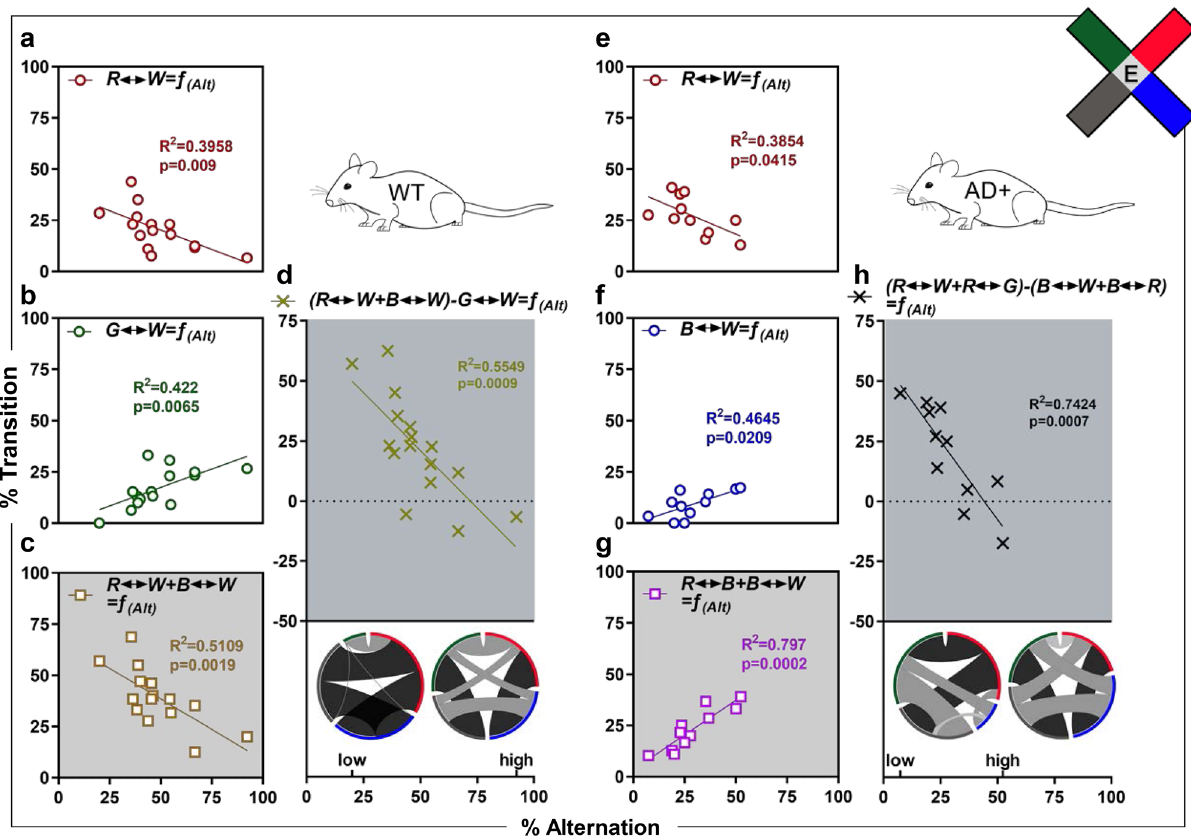
Figure 3. Correlation between alternation and color transitions in 8.5-month-old WT and AD + mice under E condition. ( a – h ) Most significant linear regressions under E condition in WT ( a – d ) and AD + mice ( e – h ) of the percentage of alternation with the percentage of single bidirectional transitions ( a , b , e , f ); or the percentage of positively paired bidirectional transitions ( c , g ); or the percentage of combined positively and negatively paired bidirectional transitions ( d , h ). ( d , h ) Inserts are chord diagrams depicting bidirectional transitions of the animals with the lowest (low) and highest (high) percentage of alternation. Mouse cohorts: 8.5-month-old WT (n = 16) and AD + (n = 11). In all graphs, individual data points, fitted line, R-squared (R 2 ) and p values are shown. The x-axis corresponds to the dependent variable (percentage of alternation) and the y-axis corresponds to the independent variables (predictors, percentage of object against the black walls is 6.00, the white object against the black walls is 9.69 (high contrast against the black walls but minimal contrast with the white floor), and the clear object against the black walls is 6.56. Similar to the color mode, in the contrast mode, WT mice showed a propensity to spontaneously alternate between the arms with the different objects (Fig. 4d). The alternation behavior was dramatically reduced, from 46 to 22%, in AD + versus WT mice as early as 8.5 months of age (Fig. 4d: Genotype, F (1,72) = 39.88, p < 0.0001). The magnitude of reduction between WT and AD + mice was even higher in 8.5- (52%) than 18-month-old (37%) mice, probably due to decreased alternation with age in WT mice ( p = 0.059; Fig. 4d: Genotype, F (1,72) = 39.88, p < 0.0001). In WT mice, there was no major preference for a particular arm, as shown by the % entries in each arm, besides a slight preference for the grey arm observed at 13 months of age only (Fig. 4e). Arm preferences were more obvious in AD + mice, with lower % entries to the black arm and higher % entries to the clear arm as compared to WT mice observed at 8.5 months of age (Fig. 4e–g; p < 0.05). Next, differences in arm transitions were identified between WT and AD + mice, further supporting impaired contrast sensitivity in diseased mice (Fig. 4h–q). When compared to WT mice, AD + mice showed decreased % grey-to-black transitions that reached significance at 18 months of age (Fig. 4h: Genotype, F (1,72) = 8.161, p = 0.0056) and significantly increased % white-to-black transitions at 13 months of age (Fig. 4i: Genotype, F (1,72) = 4.868, p = 0.0306). In addition, AD + compared to WT mice showed differences in % white-to-clear tran- sitions, at both 8.5- and 13-months of age (Fig. 4j: Genotype x Age: F (2,72) = 4.397, p = 0.0158). At a later stage, AD + mice exhibited increased % grey-to-clear and decreased % clear-to-white transitions (Fig. 4k,l; p < 0.05). Interestingly, the 8.5-month-old AD + mice showed a significant increase in % clear-to-grey transitions (Fig. 4m: p = 0.0004) along with lower % white-to-grey transitions (Fig. 4n: p < 0.05). Chord diagrams of the most frequent (Fig. 4o) and least frequent unidirectional transitions (Fig. 4p) reflect the differences between WT and AD + mice. Finally, analysis of bidirectional transitions revealed differences in contrast sensitivity between WT and AD + mice that pertained to the discrimination of grey and black (Genotype: F (1,72) = 7.818, p = 0.0066), white and clear (Genotype x Age: F (2,72) = 4.084, p = 0.0209), black and white (Genotype: F (1,72) = 6.098, p = 0.0159), and grey and